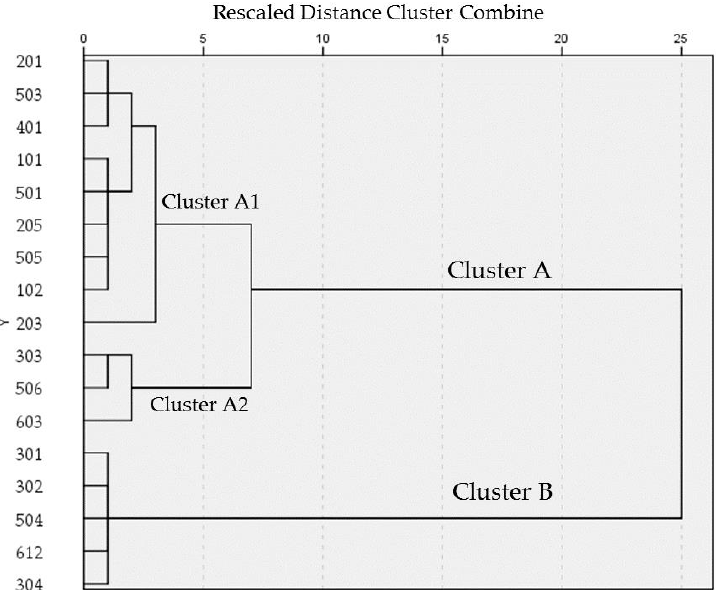
Figure 8. Dendrogram for hierarchical cluster analysis of Zn, Cu, Pb and As concentrations and flows (Euclidean, Ward method).